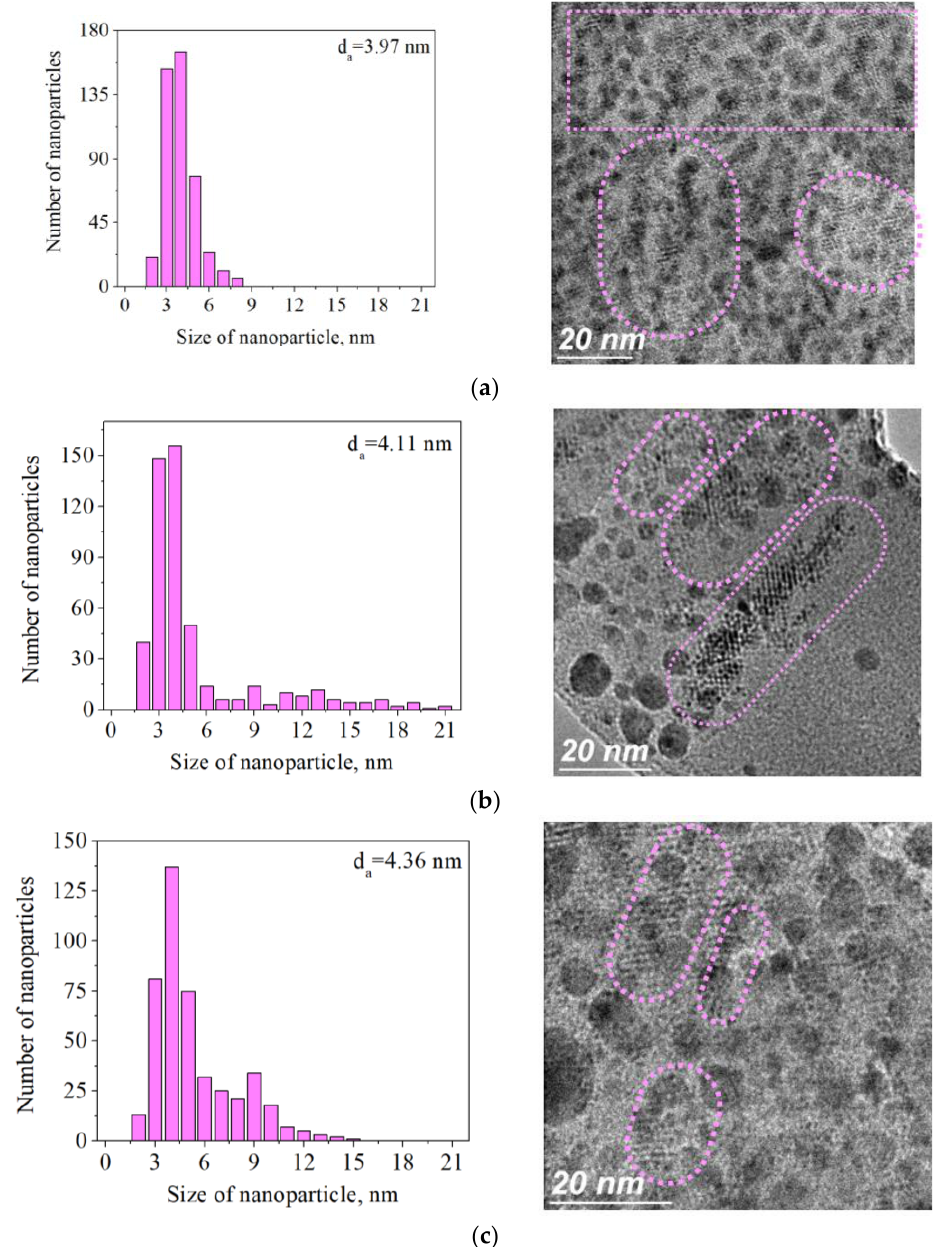
Figure 2. Microphotographs and the corresponding size distribution of Ag particles for the studied samples (d a is the average diameter): ( a ) AgMOR; ( b ) AgFeMOR; ( c ) FeAgMOR.